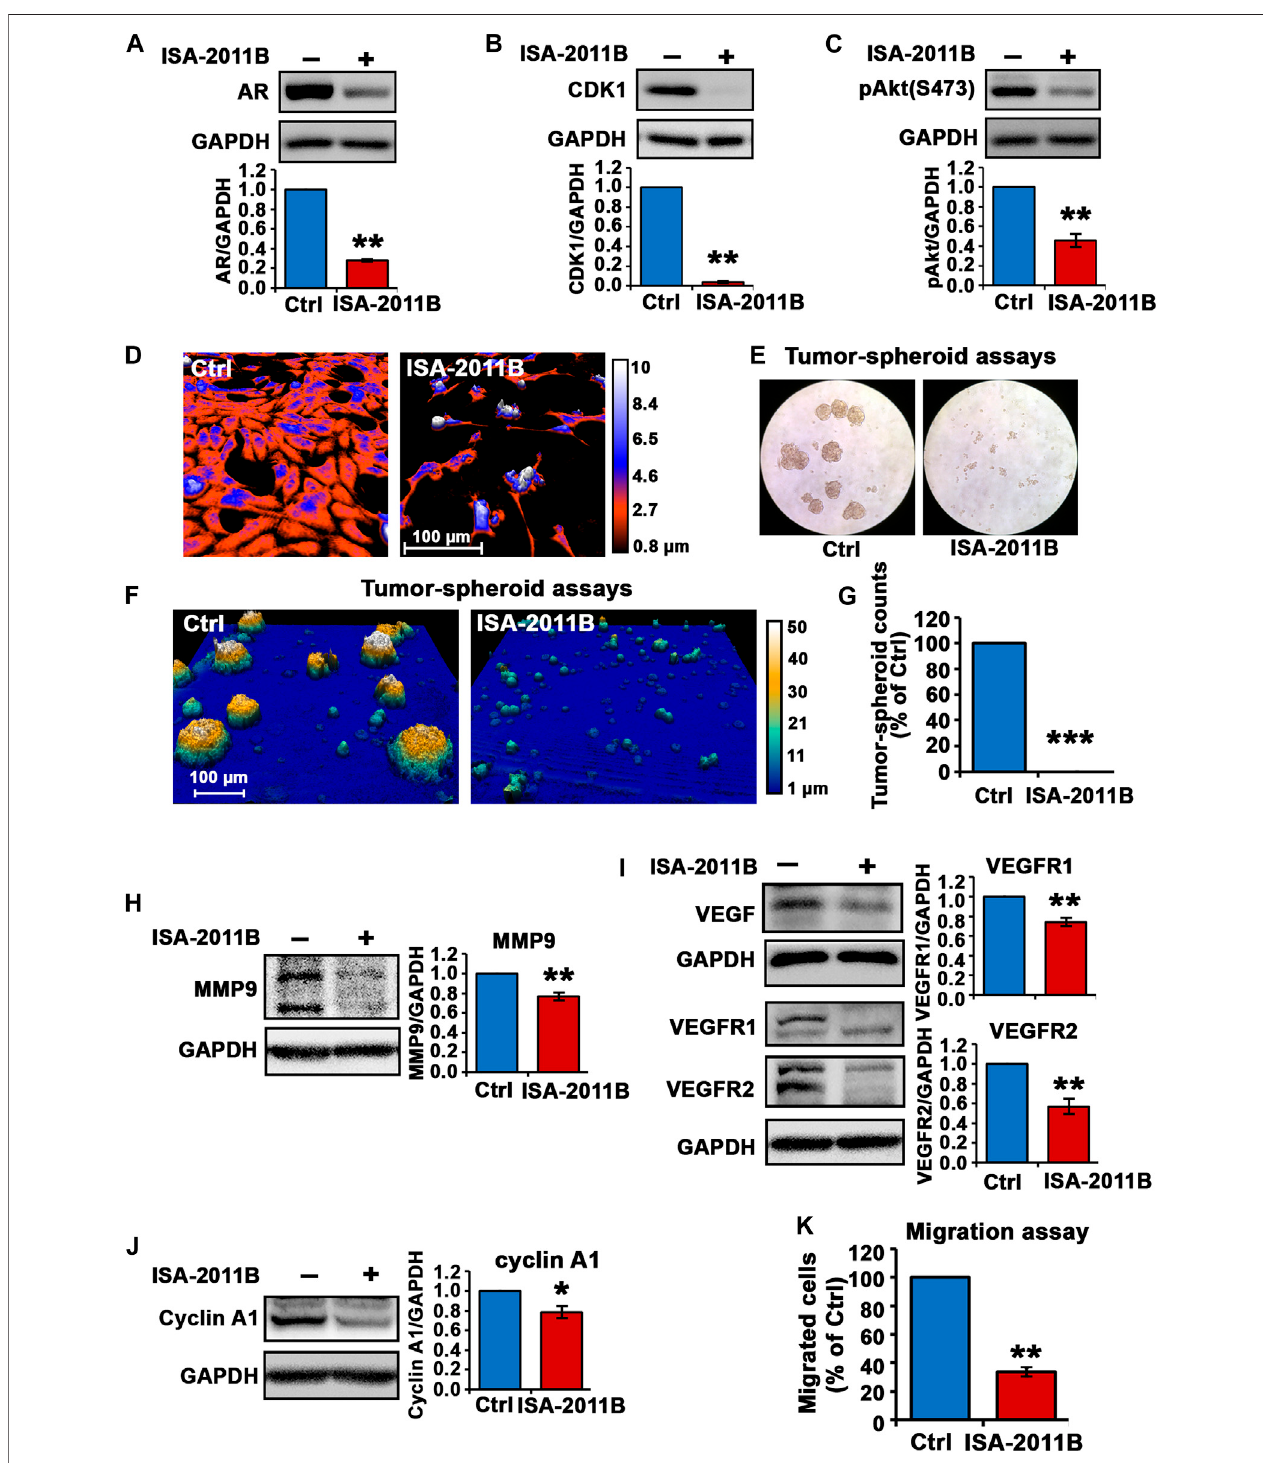
FIGURE 3 | Inhibition of total PIP5K1 α by its inhibitor ISA-2011B on functional pathways in C4-2 cells. (A – C) The effect of ISA-2011B on the expression of AR, CDK1 andpAKT inC4-2 cellswasdetermined usingimmunoblotanalysis.Quanti fi cationsoftheimmunoblotsareshown inthelowerpanels. (D) Representativelive-cell images from the digital Holomonitor M4 microscope shows the morphological changes in C4-2 cells that were treated with vehicle control (Ctrl) or ISA-2011B for 48 h. Representative images of tumor spheroids derived from cells treated with vehicle control (Ctrl) or ISA-2011B were taken by using a light microscope in (E) and the DigitalHolomonitorM4microscope (F) . (G) ThecountsoftumorspheroidsderivedfromC4-2cellstreatedwithvehicleorISA-2011Bareshown. (H – J) TheeffectofISA- 2011Bon the expression of MMP9, VEGF,VEGFR1, VEGFR2 and Cyclin A1was determined using immunoblot analysis. Quanti fi cations ofthe immunoblotsare shown intherightpanels. (K) TheeffectofISA-2011BonthemigratoryabilityofC4-2cellswasdeterminedusingmigrationassays.Datainthis fi gureispresentedastheaverage of three independent experiments (±SE). Student ’ s t -test was used in the analysis. * p < 0.05 or ** p < 0.01 are indicated.